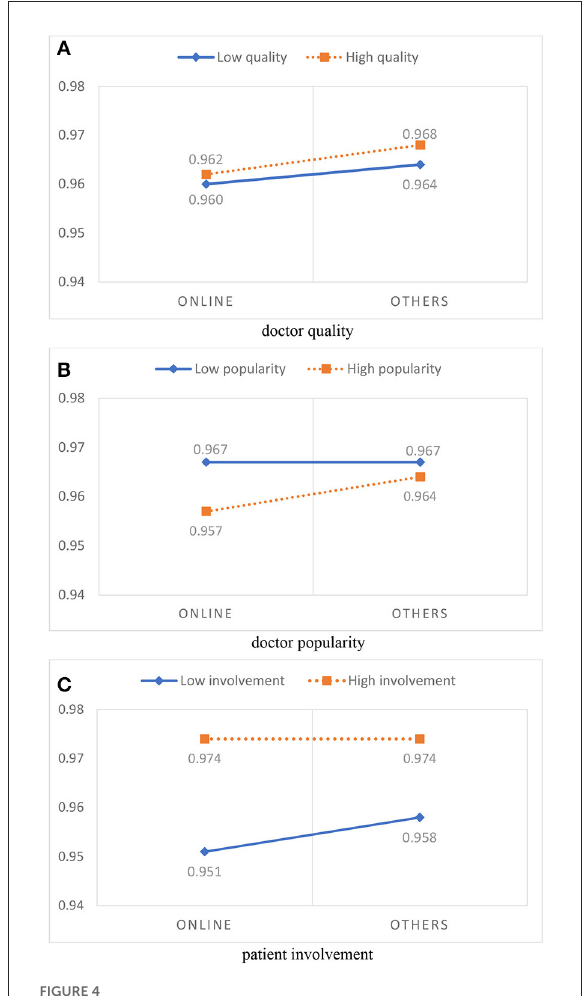
popularity. (C) Patient